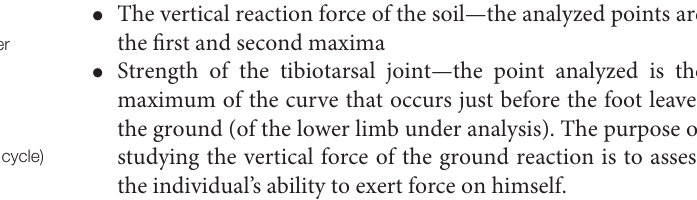
TABLE 1 | Analyzed spatiotemporal, kinematic, and kinetic parameters. Spatiotemporal Step time and their asymmetry (s) parameters Step length and their asymmetry (m) Step width and their asymmetry (m) Velocity and global velocity (average velocity between both lower limbs) (m/s) Cadence and their asymmetry (number of steps per minute) Stance phase and their asymmetry (% gait cycle) Swing phase (% gait cycle) Single support phase and their asymmetry (% gait cycle) Kinematic parameters Ankle joint’s sagittal plane Foot strike